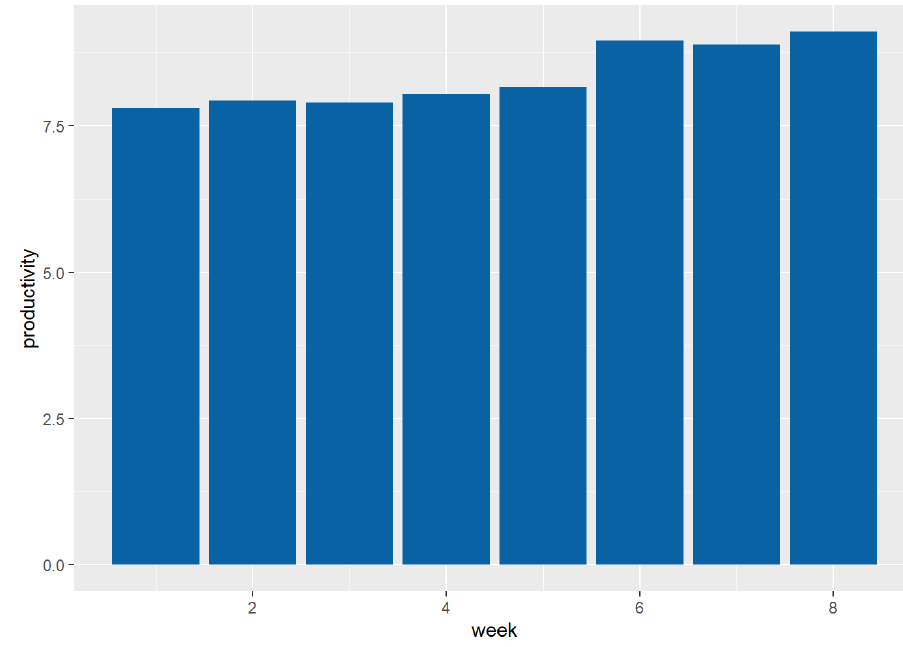
Figure 11. Team 1 progress.